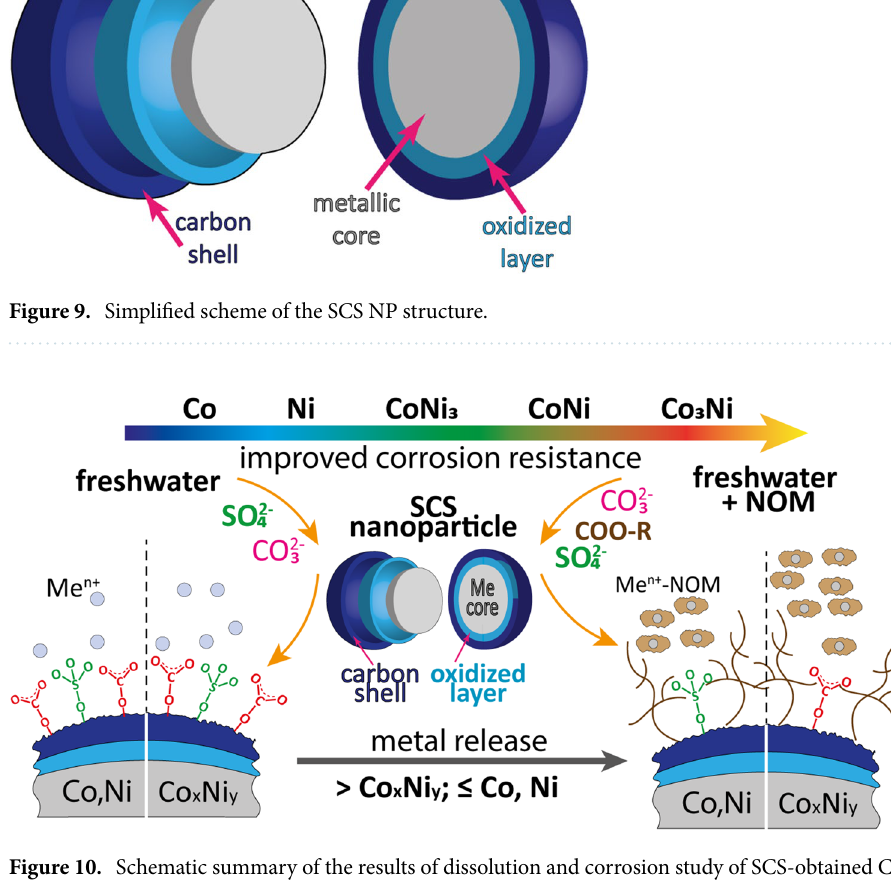
Figure 10. Schematic summary of the results of dissolution and corrosion study of SCS-obtained Co–Ni